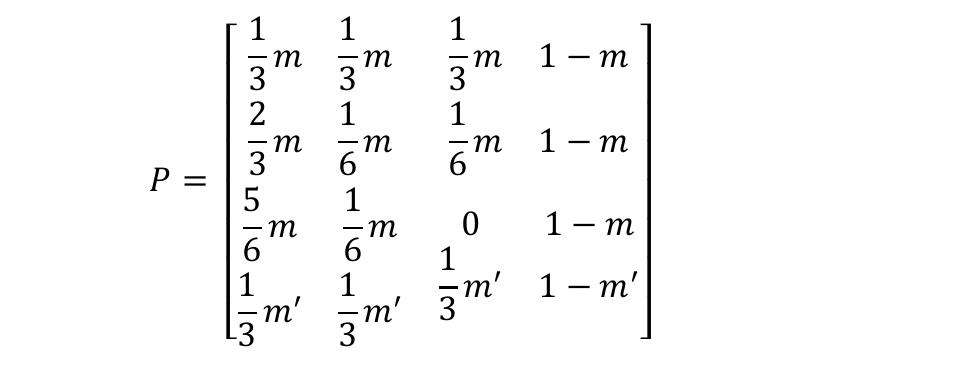
Figure 7. State transition diagran ( N = 5).